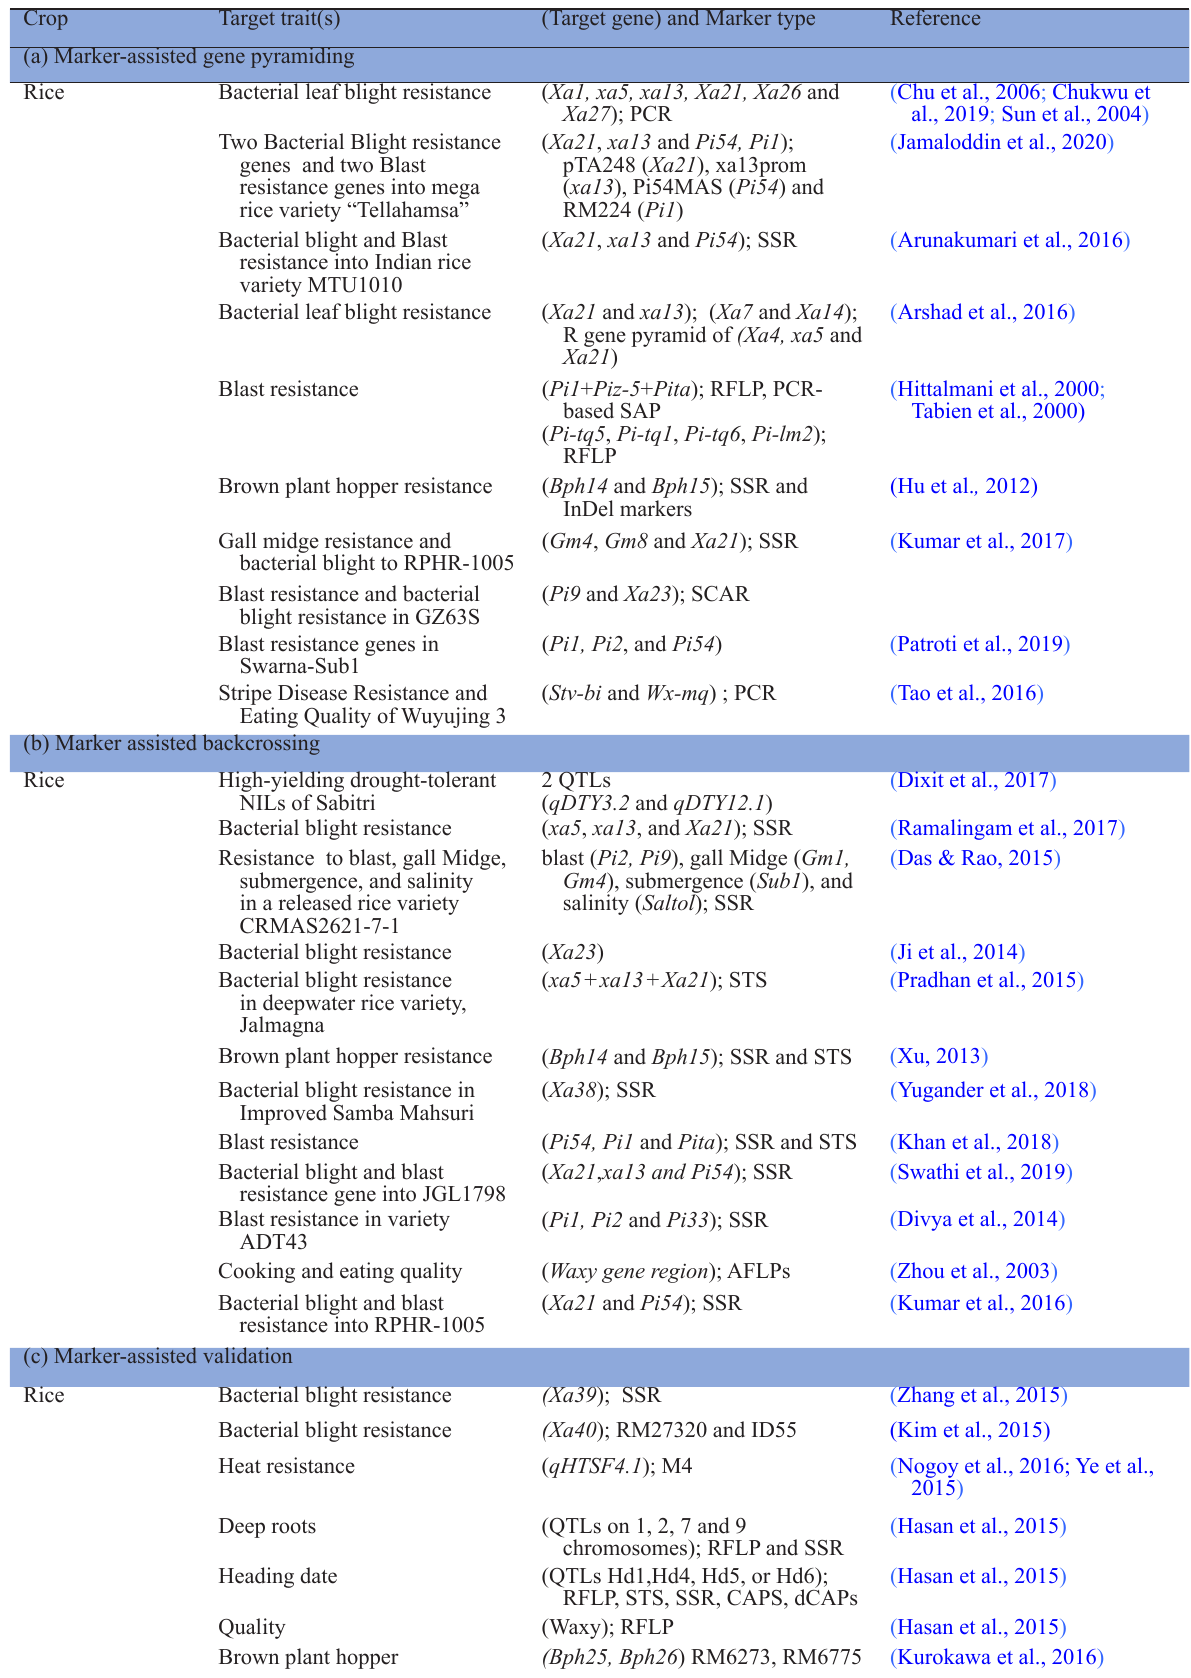
Table 2. Breeding works in rice using